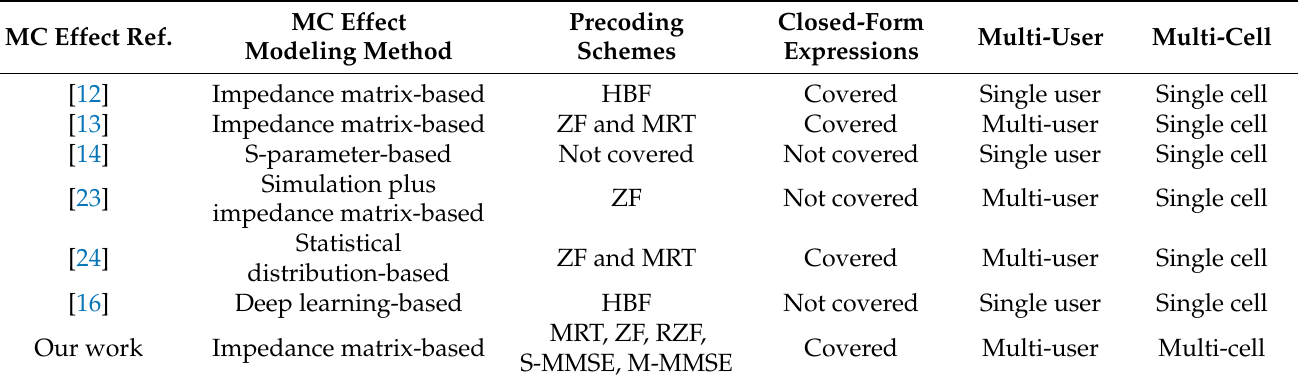
Table 1. Comparison with previous representative research